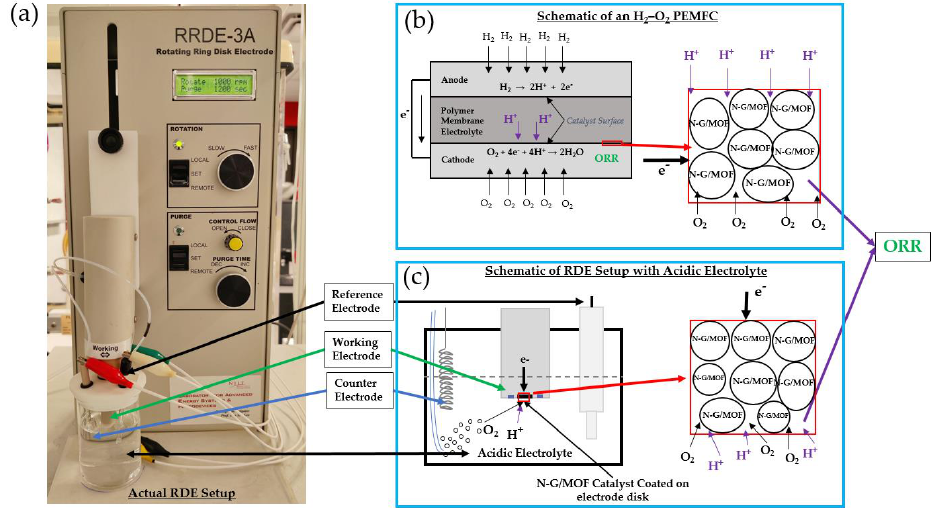
Figure 9. Creating the acidic medium ORR environment on the PEMFC cathode within an RDE setup: ( a ) actual test vial of our RDE setup; ( b ) schematic of working process of the H 2 -O 2 PEMFC; and ( c ) schematic of the test vial of RDE setup.